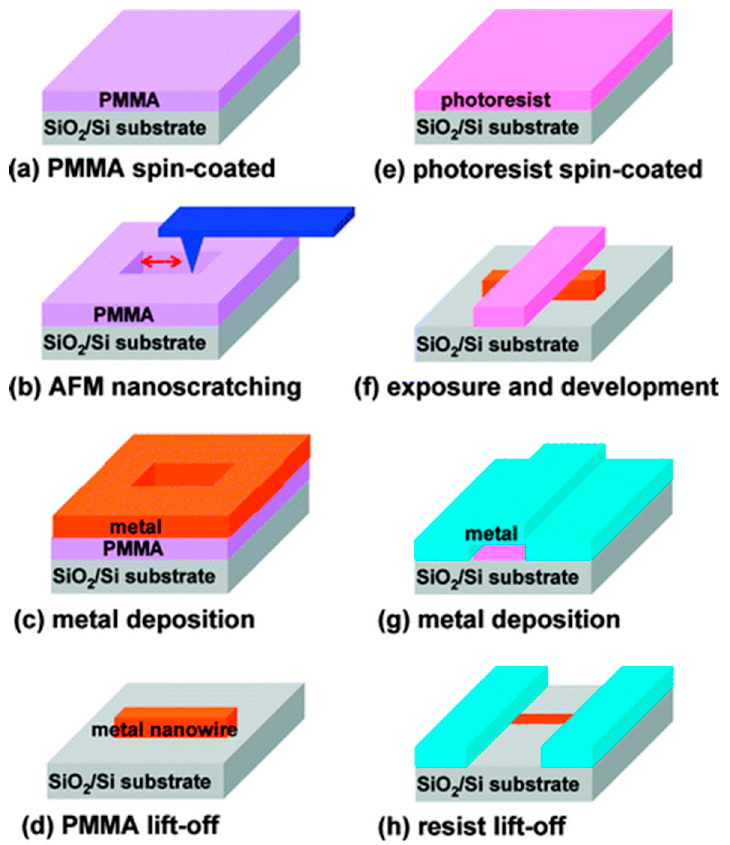
Figure 19. The fabrication procedures of single Au nanowire using the combination of the TBN approach, lift-o ff and the photolithography method: ( a ) polymethyl methacrylate (PMMA) was spin-coated on the silicon / silicon dioxide substrate, ( b ) nanogroove was fabricated on the surface of PMMA thin-film by the tip-based nanomachining / nanoscratching (TBN) method, ( c ) a layer of metal was deposited above the PMMA thin-film, ( d ) metal nanowire was fabricated by lift-o ff process, ( e ) a layer of photoresist was spin-coated on the silicon / silicon dioxide substrate with metal nanowire, ( f ) the photoresist was exposed and developed, ( g ) a layer of metal was deposited above the substrate with metal nanowire and photoresist, ( h ) the resist was removed by lift-o ff process